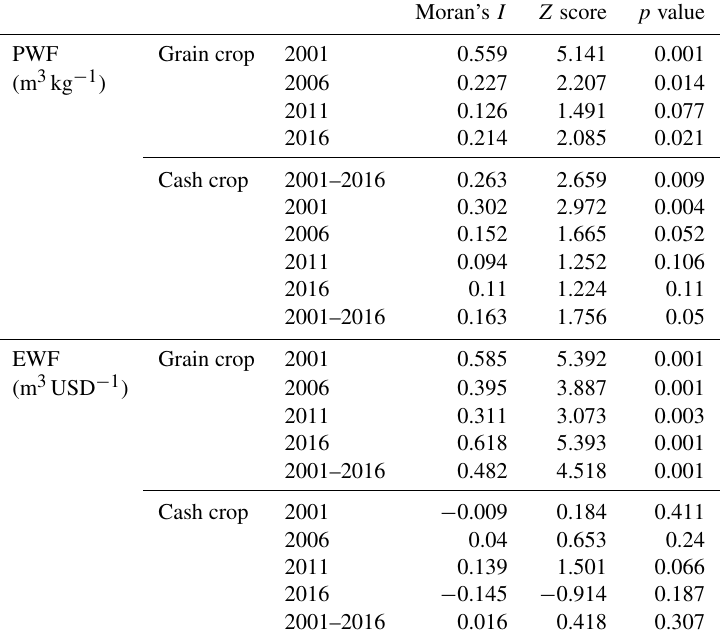
Table 4. Moran’s I test for production-based water footprint (PWF) and economic value-based water footprint (EWF) of crop production.